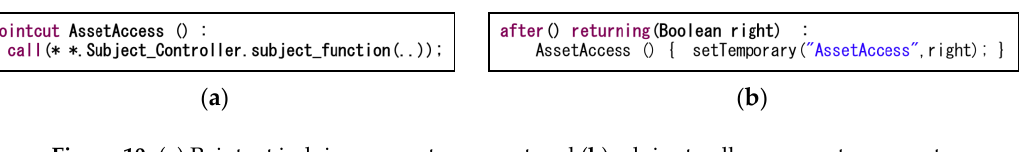
Figure 10. ( a ) Pointcut judging access to an asset and ( b ) advice to allow access to an asset.